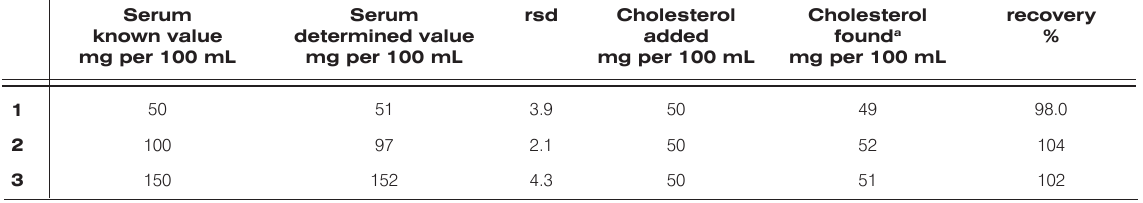
Table 1. Determination of cholesterol in real blood serum